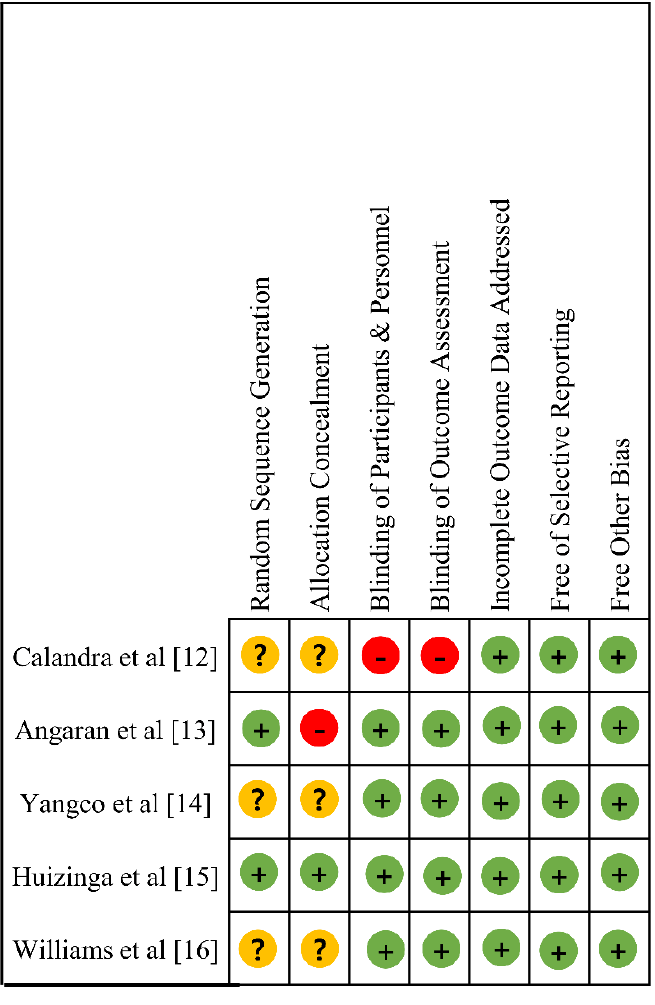
Figure 2. Risk of bias in the included randomized controlled studies.